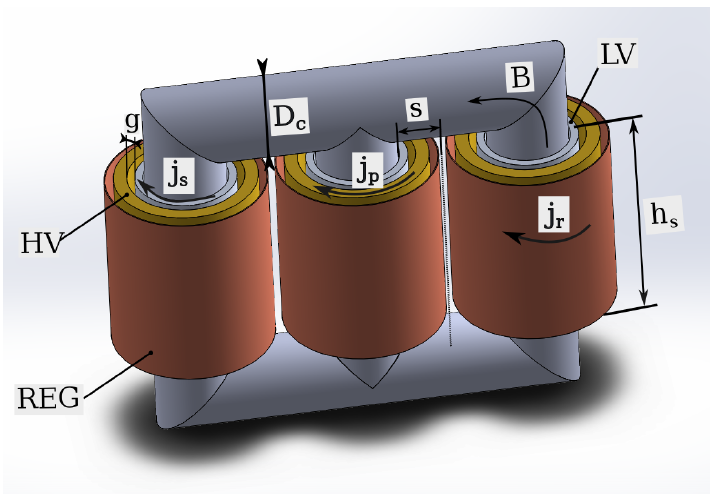
Figure 2. Schematic view the optimized key-design parameters of a three phase, core-form large power transformer. All of the optimized, independent key-design parameters have been noted on the